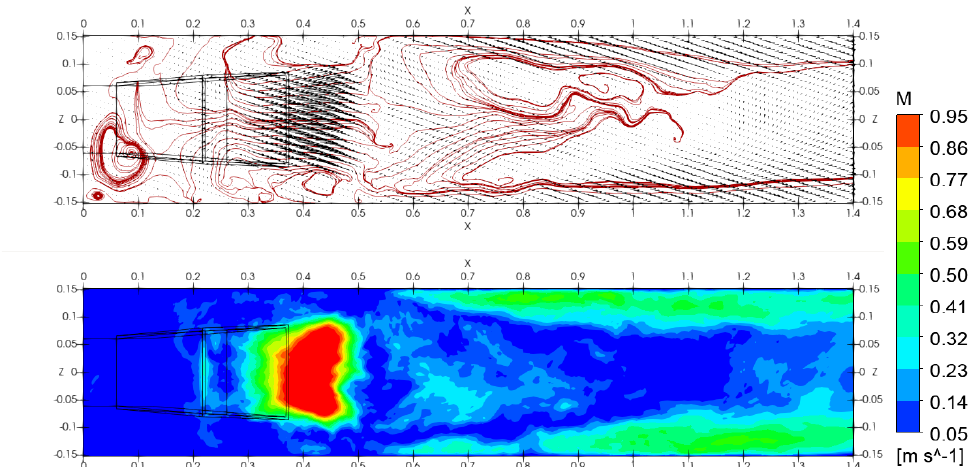
Figure 25. LBM, vector lines ( top ) and the magnitude of time-averaged 2D velocity ( bottom ) in horizontal plane ( y = 135mm ) .